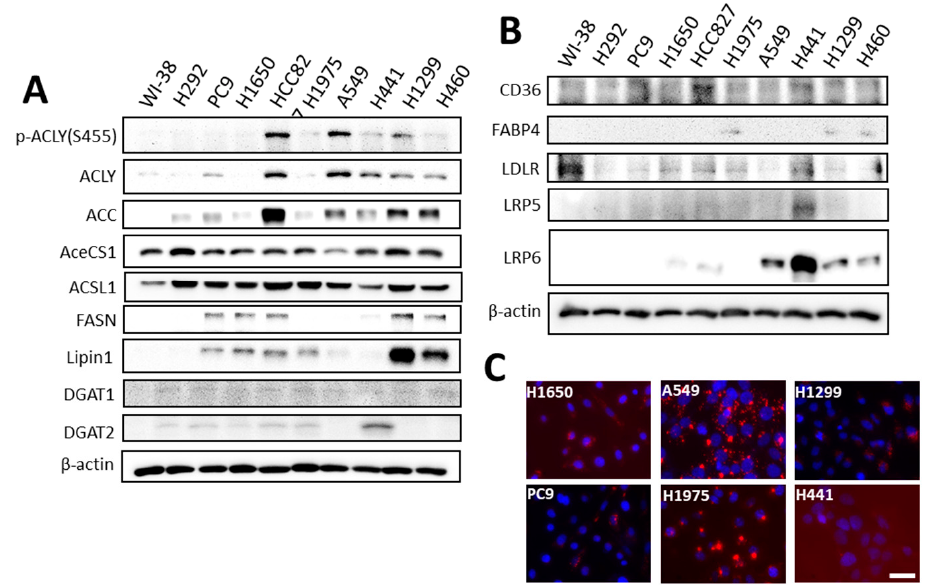
Figure 1. Expressions of proteins involved in lipogenesis and lipid uptake in lung cancer cells. The relative abundance of target proteins was measured using nine lung cancer cell lines and compared with the normal lung cell line, WI-38. The total protein was harvested when cell growth reached 80% complacence. The expressions of genes involved in lipogenesis ( A ) and lipid uptake ( B ) were measured using immunoblot analyses. The lipid uptakes in the lung cancer cells were recorded 2 h after incubation with the fluorescence-labeled low-density lipoprotein (BODIPY™ FL labeled LDL, Invitrogen, Waltham, MA, USA) and labeled in red. Cell nuclei were counterstained with Hoechst 33342 and labeled in blue. Images were taken at 400 × magnification (scale bar, 50 µ m) ( C